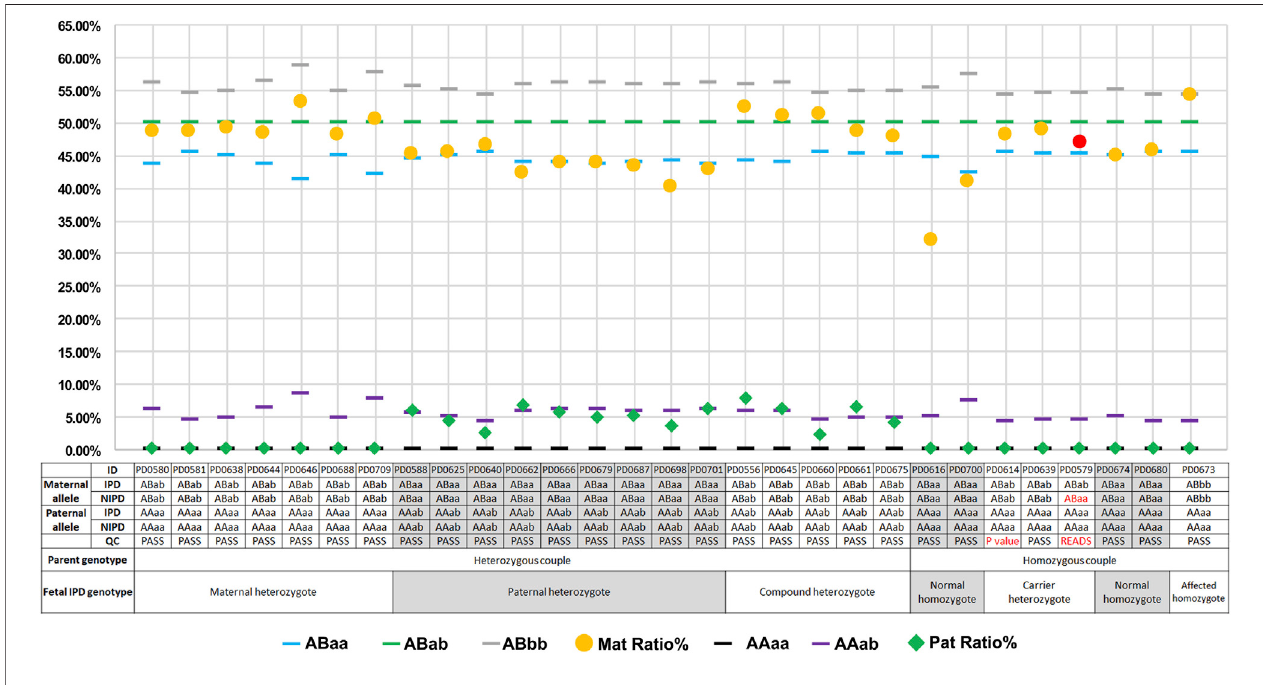
FIGURE 3 | Plots of mutation percentages in the plasma DNA and maternal – fetal genotypes of 29 cases. Blue ( ), green ( ), gray ( ), black ( ), and purple ( ) rectangles denote theoretical mutation deviation for genotypes of ABaa, ABab, ABbb, AAaa, and AAab deduced using half of FF, respectively. Orange circles ( ) and green diamonds ( ) denote observed maternal and paternal mutation percentages in cfDNA, respectively, while discordant maternal is indicated by a red circle ( ). The table below shows deduced maternal – fetal genotype and the corresponding number of each case. Discordant and failed QC value cases are indicated by red color. IPD, invasive prenatal diagnosis; NIPT, noninvasive prenatal testing; Mat, maternal; Pat,